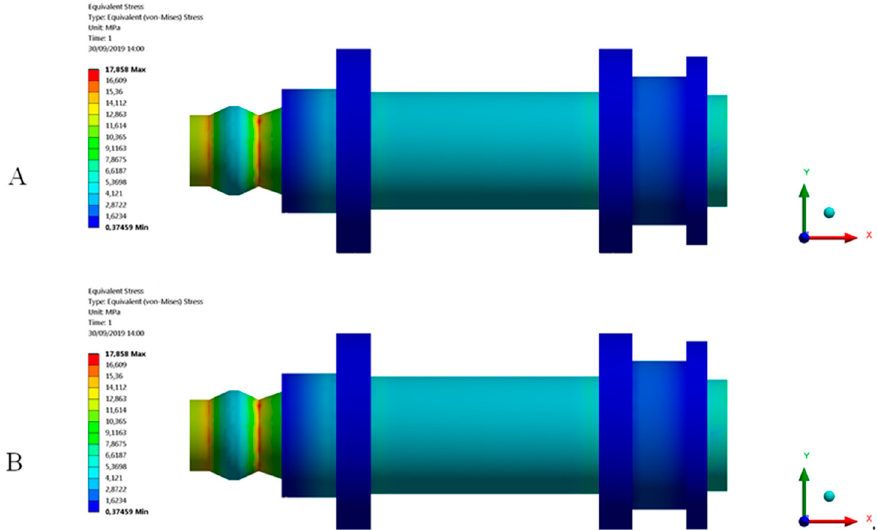
Figure 22. Field of Von-Mises stress obtained in the mechanical simulations: ( A ) Z-axis printing direction; ( B ) X-axis printing direction.